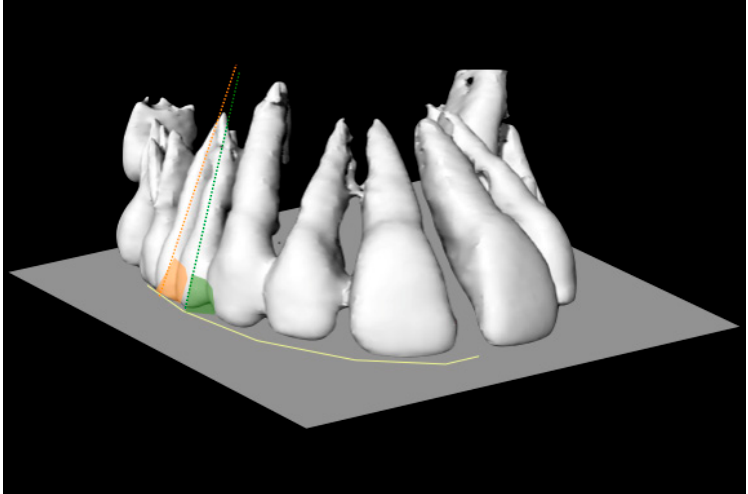
Figure 3. Measurement of buccolingual inclination on CBCT. Buccolingual inclination was identified as the angle between the Proper vertical axis and the projection of Proper horizontal axis on FACC plane.